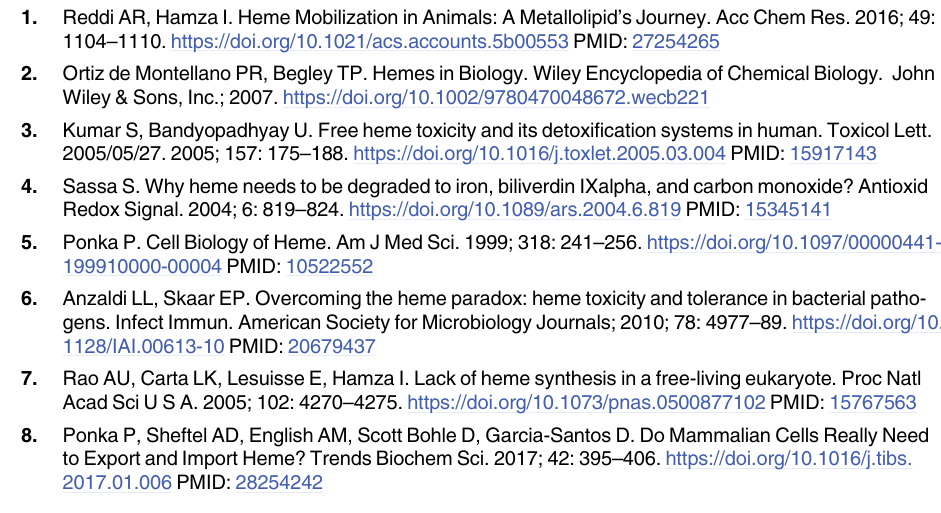
S7 Table. List of